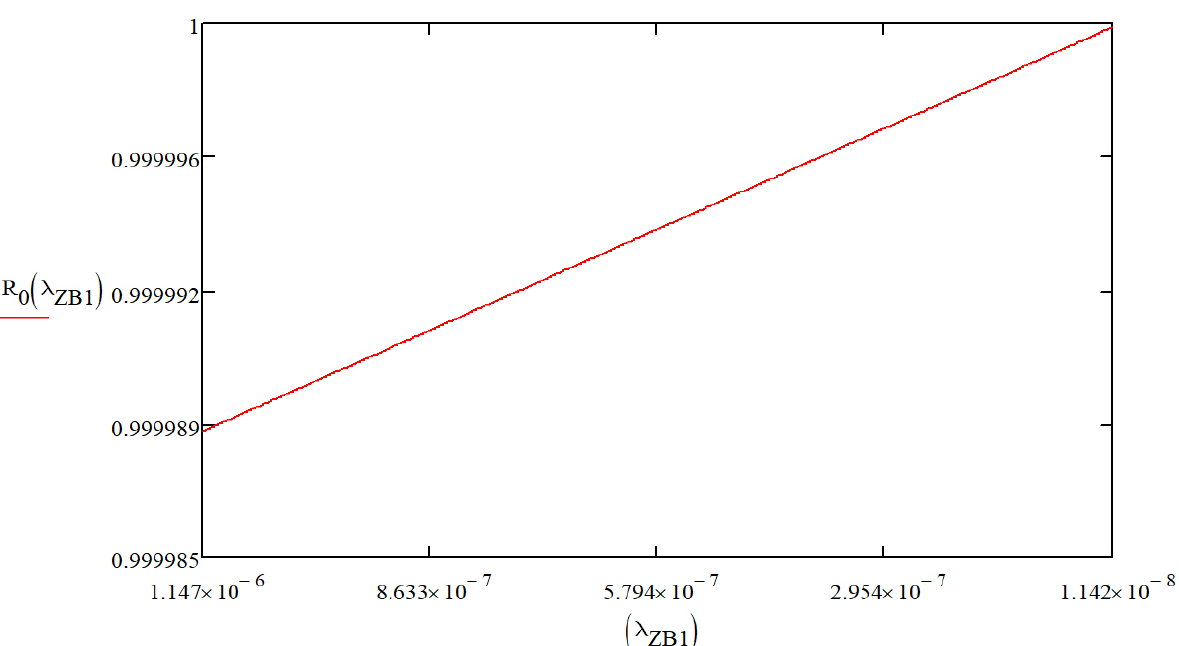
Figure 9. Relationship for the probability of a fire alarm system staying in a state of full fitness R 0 as a function of intensity λ ZB 1 of the transition from a state of full fitness to a state of safety